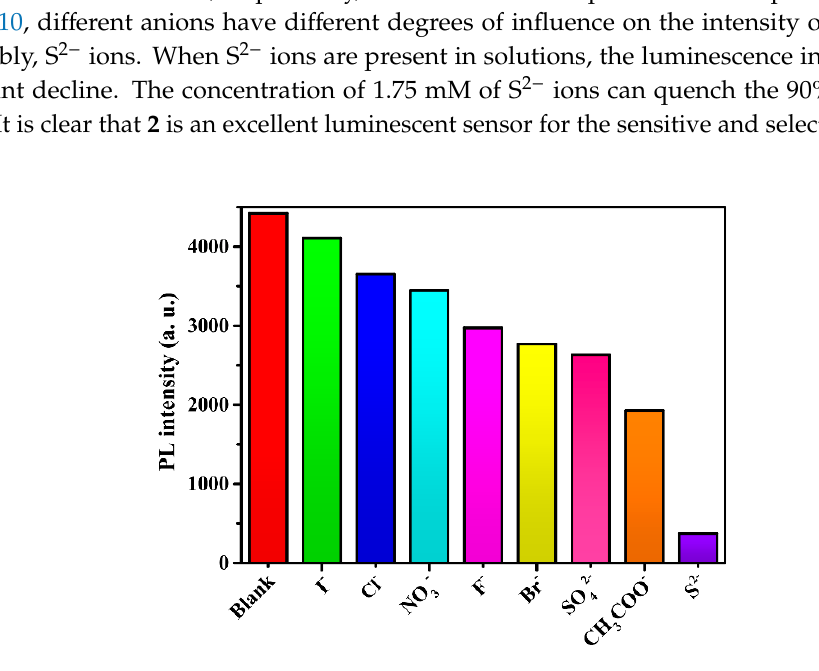
Figure 10. Luminescence intensities of 2 in different anions.